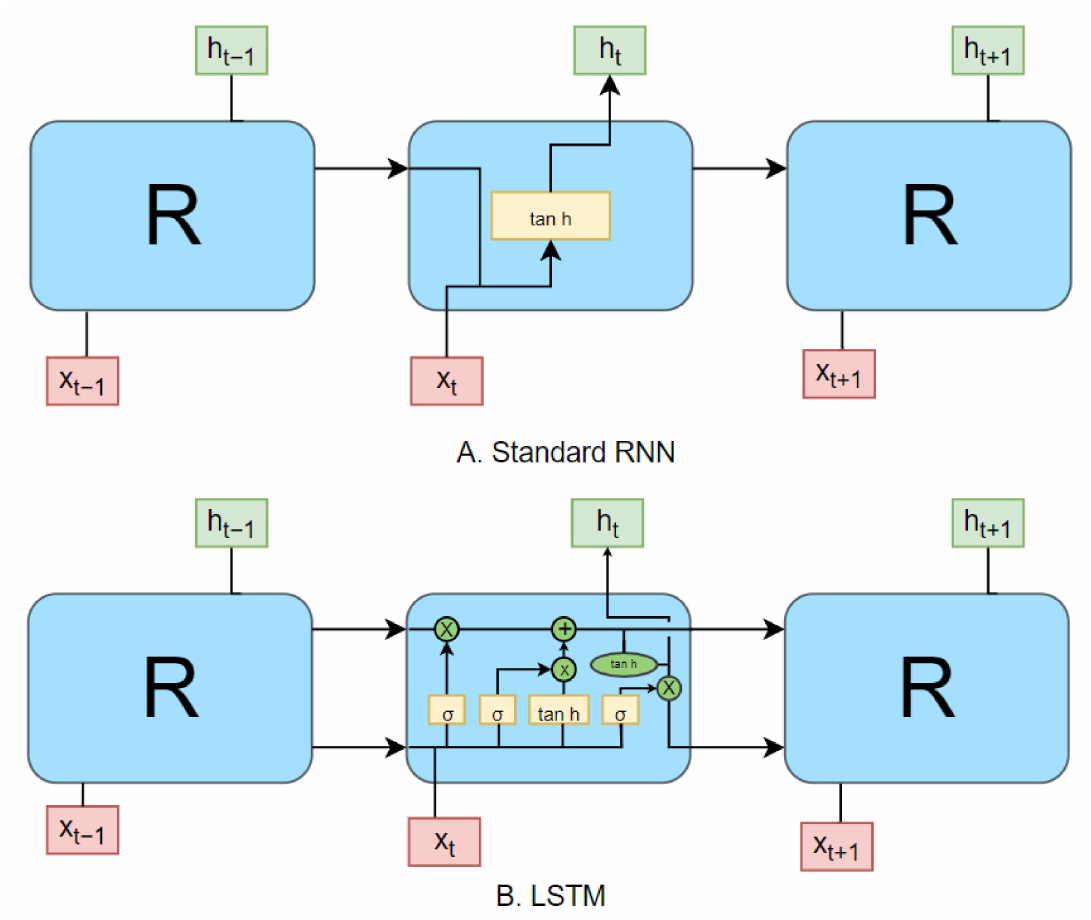
Figure 9. A standard RNN with single layer ( A ) versus LSTM with four layers ( B ). The prediction can be carried out with the help of deep learning [39].